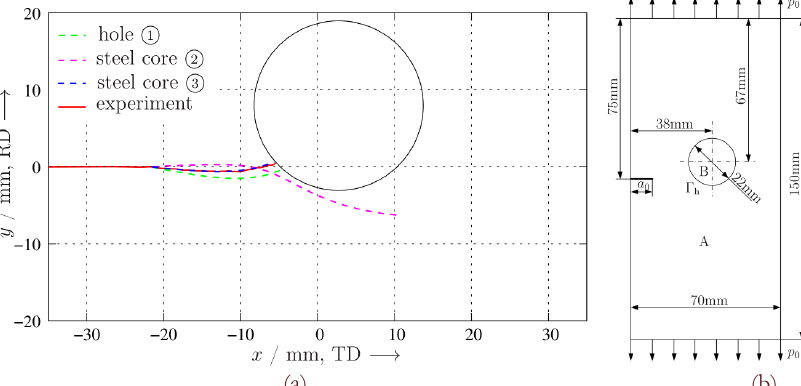
Figure 2: (a) Comparison of experimental and numerically predicted crack paths for three different model configurations, (b) aluminum alloy specimen with hole and cylindrical steel core, incipient crack length a 0 and loading p